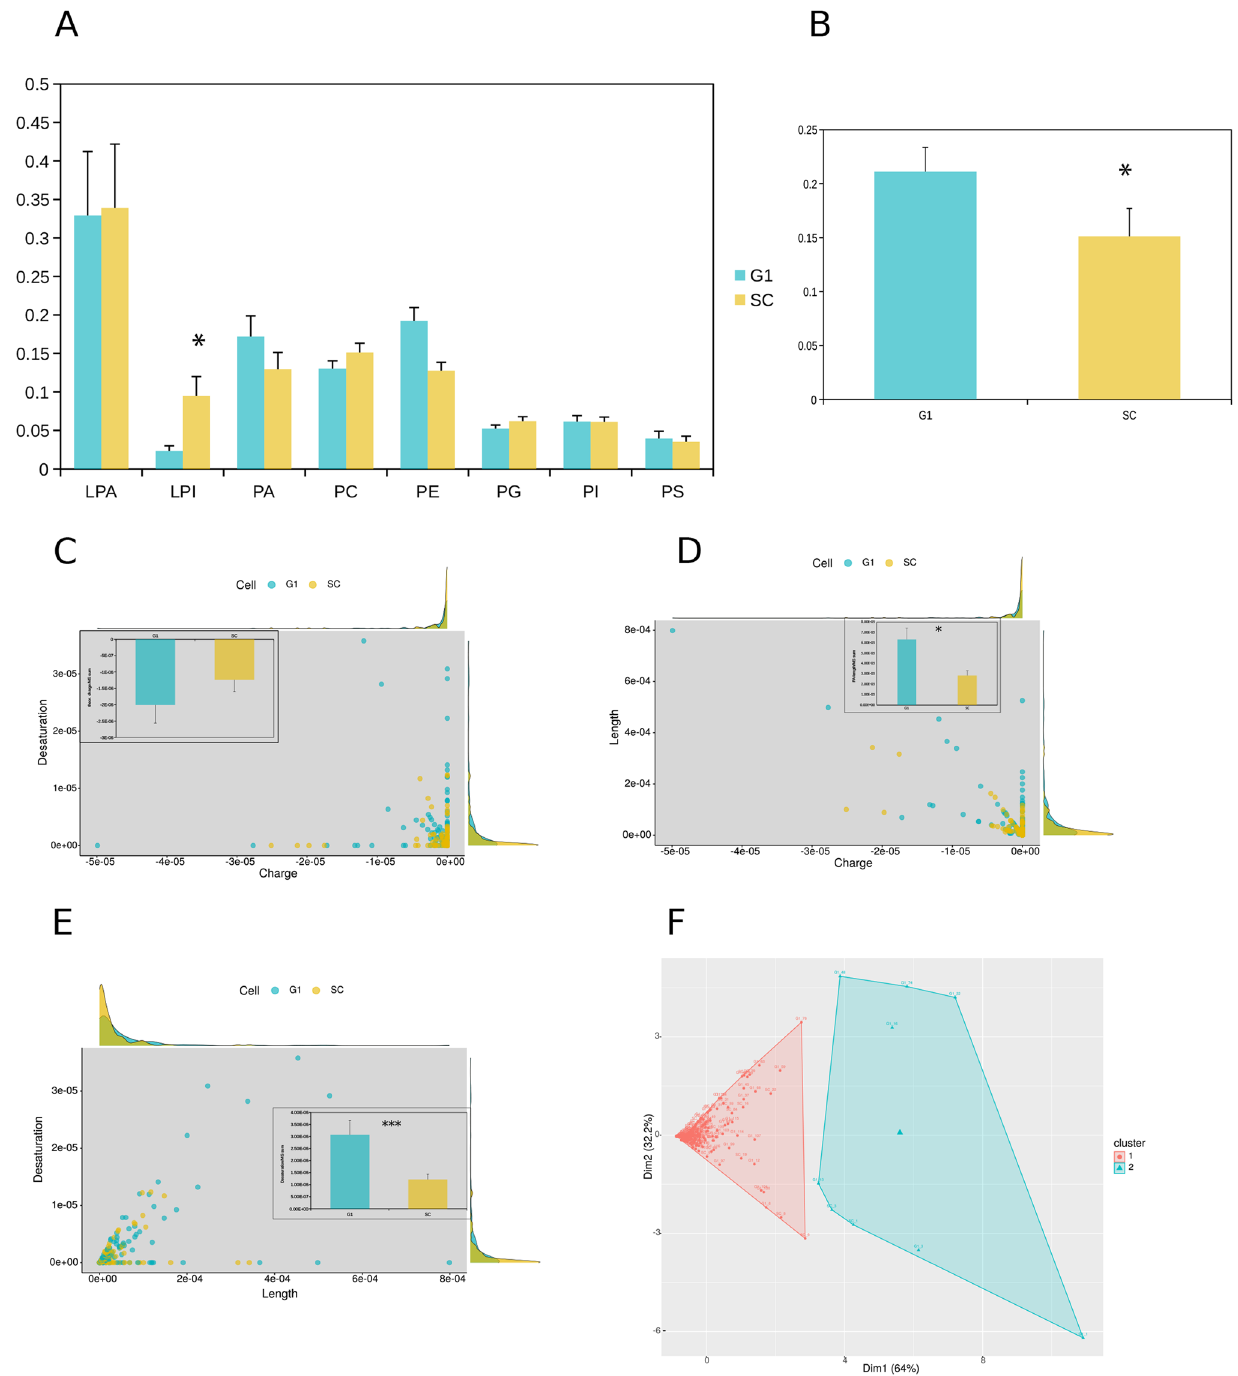
Figure 1. Lipid distribution in FGFR2-associated micro-domains. ( A ) Comparison between GRB2-depleted (G1) and control (SC) of identified lipid classes from mass spectrometric measurements of FGFR2 DRM extracts. The data has been normalized to the summarized signal of each of 3 replicates (see Materials and Methods). Error bars represent standard deviation. ( B ) Relative cholesterol content of DRMs from G1 and SC. ( C ) Scatter blot with densitogram of calculated signal adjusted charge (x-axis) versus fatty acid desaturation (y-axis) of identified phospholipids between G1 and SC. Insert: bar graph of the average adjusted head group charge. ( D ) Scatter blot with densitogram of calculated signal adjusted charge (x-axis) versus signal adjusted chain length (y-axis). Insert: bar graph of the average fatty acid chain length, p = 0.019. ( E ) Scatter blot with densitogram of calculated signal adjusted fatty acid chain length (x-axis) versus fatty acid desaturation (y-axis) of identified phospholipids between G1 and SC. Insert: bar graph of the average fatty acid desaturation, p = 0.000516. ( F ) Scatter blot representation of dimension 1 and 2 from k-means cluster analysis using ward method based on charge, fatty acid length and saturation. Cluster 2 consists predominantly of G1